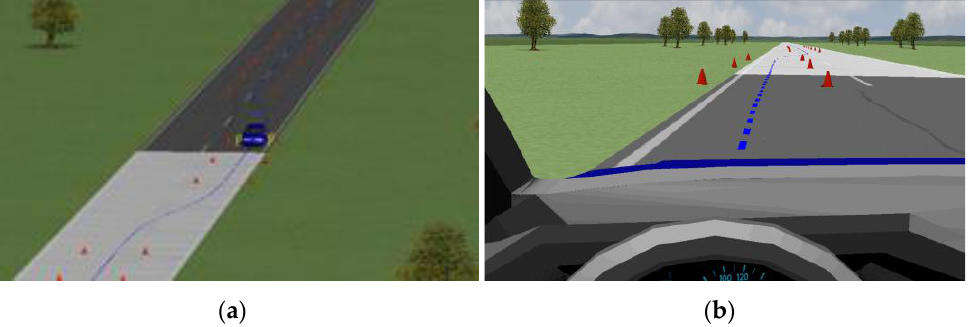
Figure 8. The joint road. ( a ) top view. ( b ) driver view.